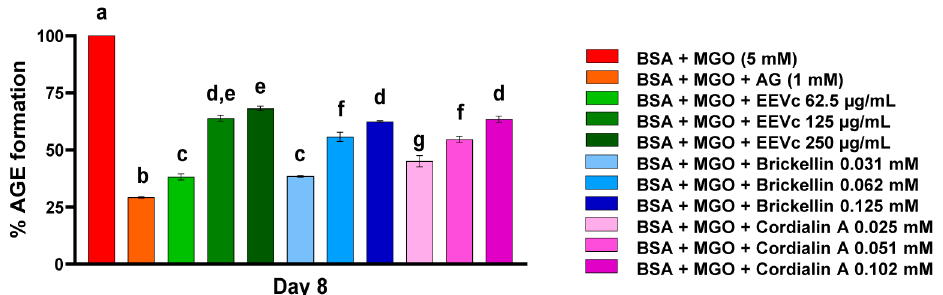
Figure 3. Percentage of AGE formation in an in vitro model system of protein glycation with BSA + MGO on day 8. BSA: bovine serum albumin; MGO: methylglyoxal; AG: aminoguanidine; EEVc: ethanolic extract of V. curassavica . For all variables with the same letter, the difference between the means is not statistically significant.